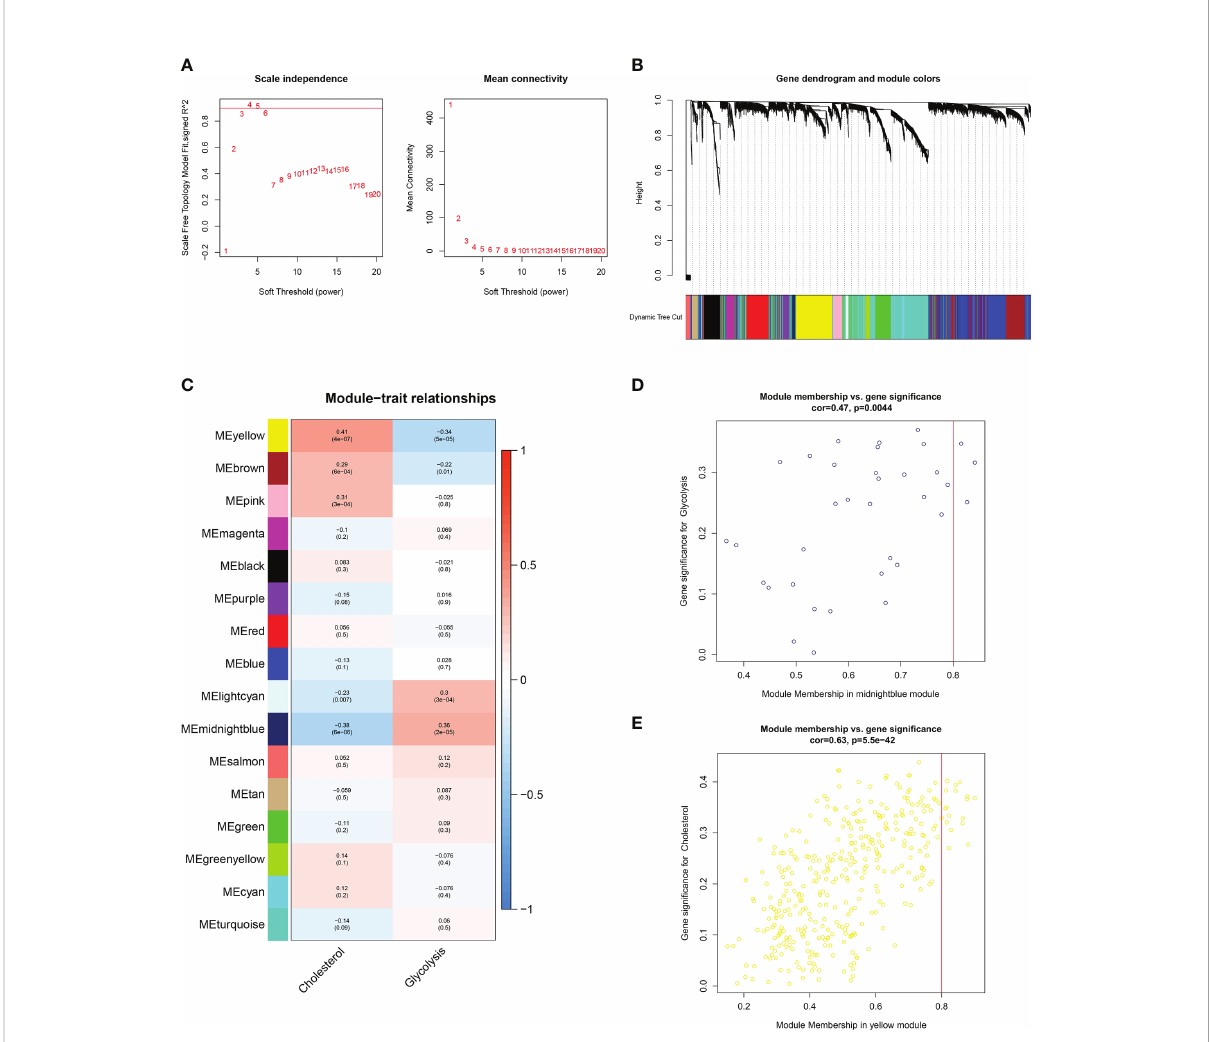
FIGURE 2 WGCNA to identify similar genes networks of GCSRGs. (A) The scale independence (left) and mean connectivity (right) of WGCNA analysis. (B) Color coding of co-expression network modules for genes. (C) Heatmap showing the correlation of gene modules and glycolysis-cholesterol synthesis. (D) Scatter plot displaying the correlation between module membership and gene signi fi cance in midnight blue network. (E) Scatter plot displaying the correlation between module membership and gene signi fi cance in yellow